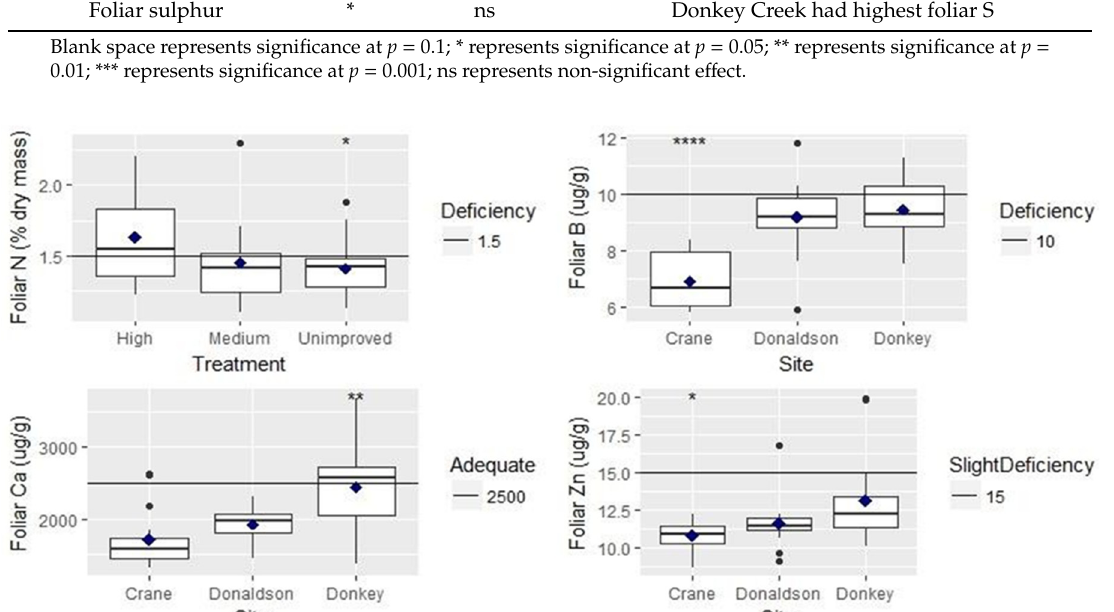
Table 2. ANOVA table for all measured variables.